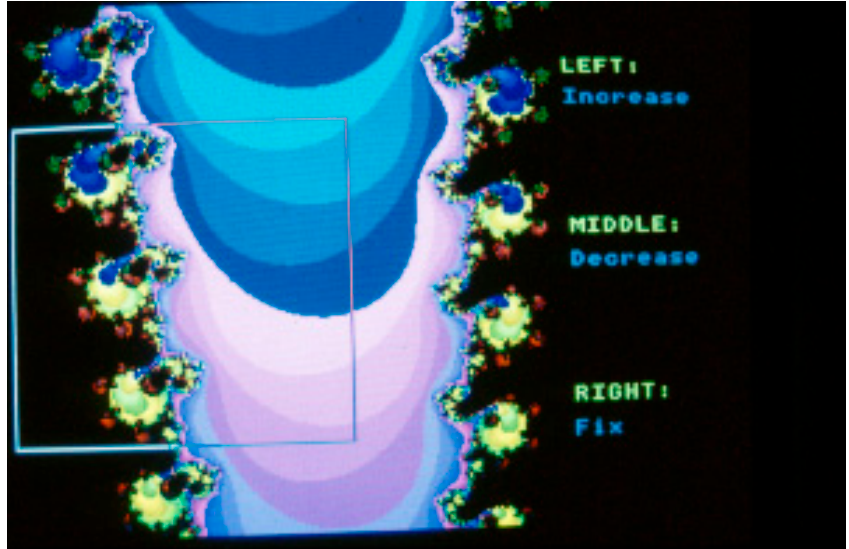
Figure 14. A screenshot, apparently derived from the Mandelbrot set, manipulated in a paintbox program, and captured on slide film by Ostoja. Published with permission. Image courtesy of the State Library of South Australia. SLSA: